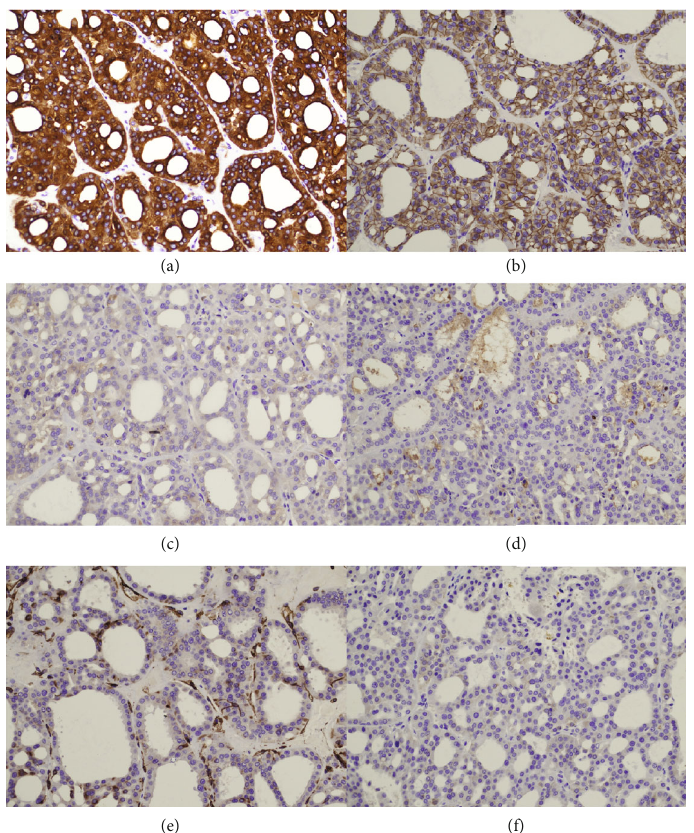
Figure 3: (a) CK7: di ff use and densely positive. (b) E-cadherin: di ff usely positive. (c) c-kit. (d) CD10. (e) Vimentin. (f) Alpha-methylacyl-CoA